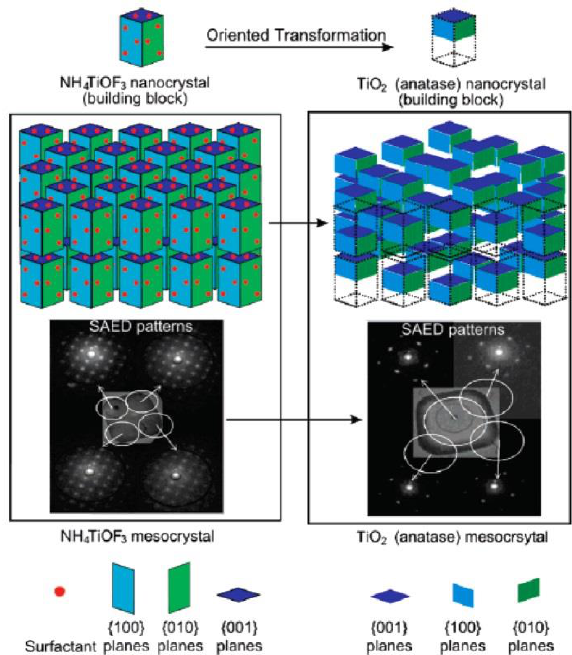
Figure 2. Schematic illustration of oriented topotactic transformation of NH 4 TiOF 3 mesocrystal to anatase TiO 2 mesocrystal. The electron diffraction (SAED) patterns of the selected area illustrate single-crystal-like diffraction behavior for both samples. Reprinted with permission from [43]. Copyright American Chemical Society, 2008.